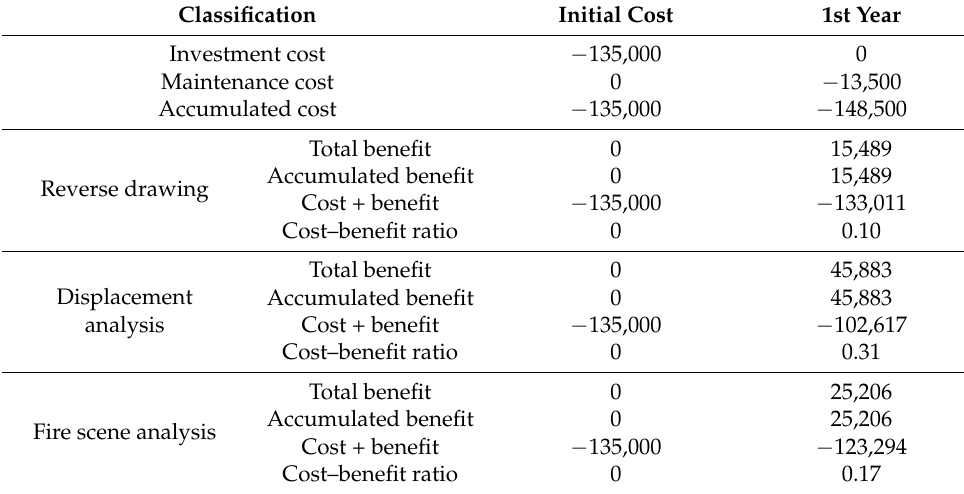
Table 7. CBA by purpose of a single case for 1 year (1000